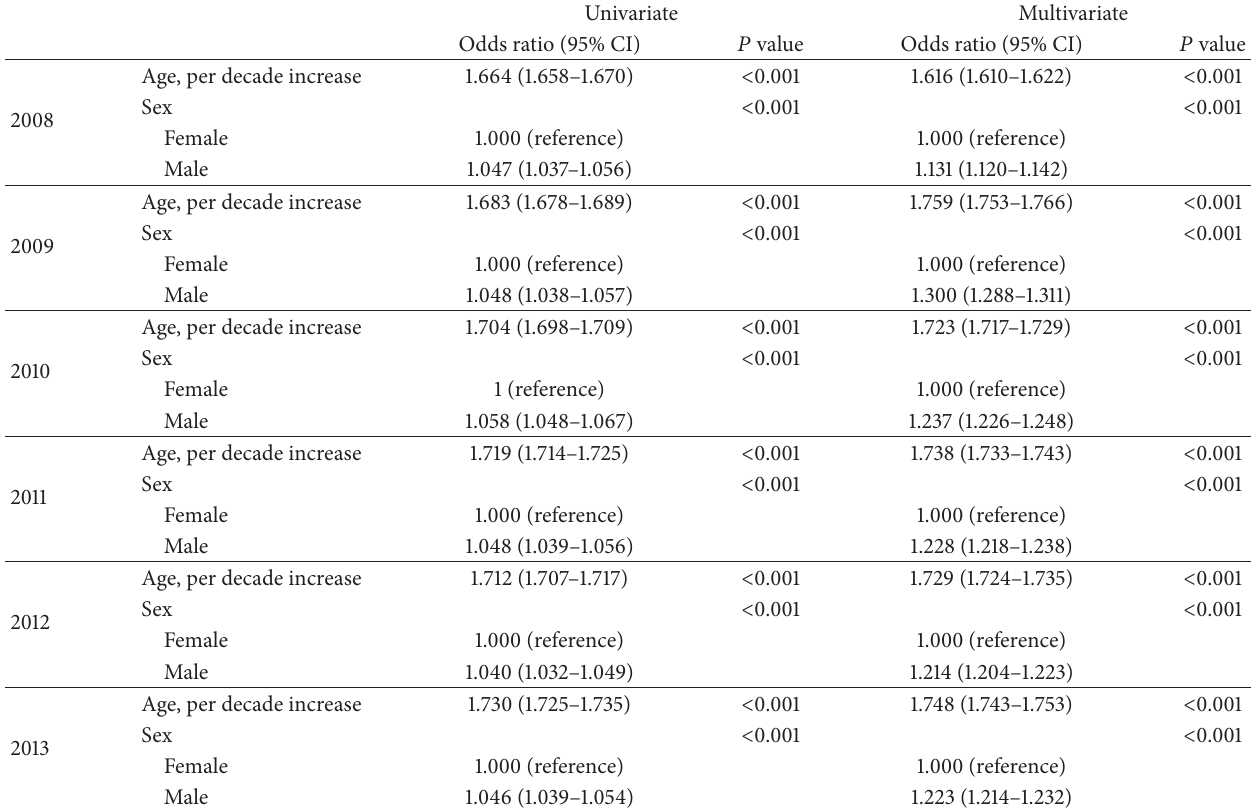
Table 3: Effect of age and gender on the prevalence of glaucoma.